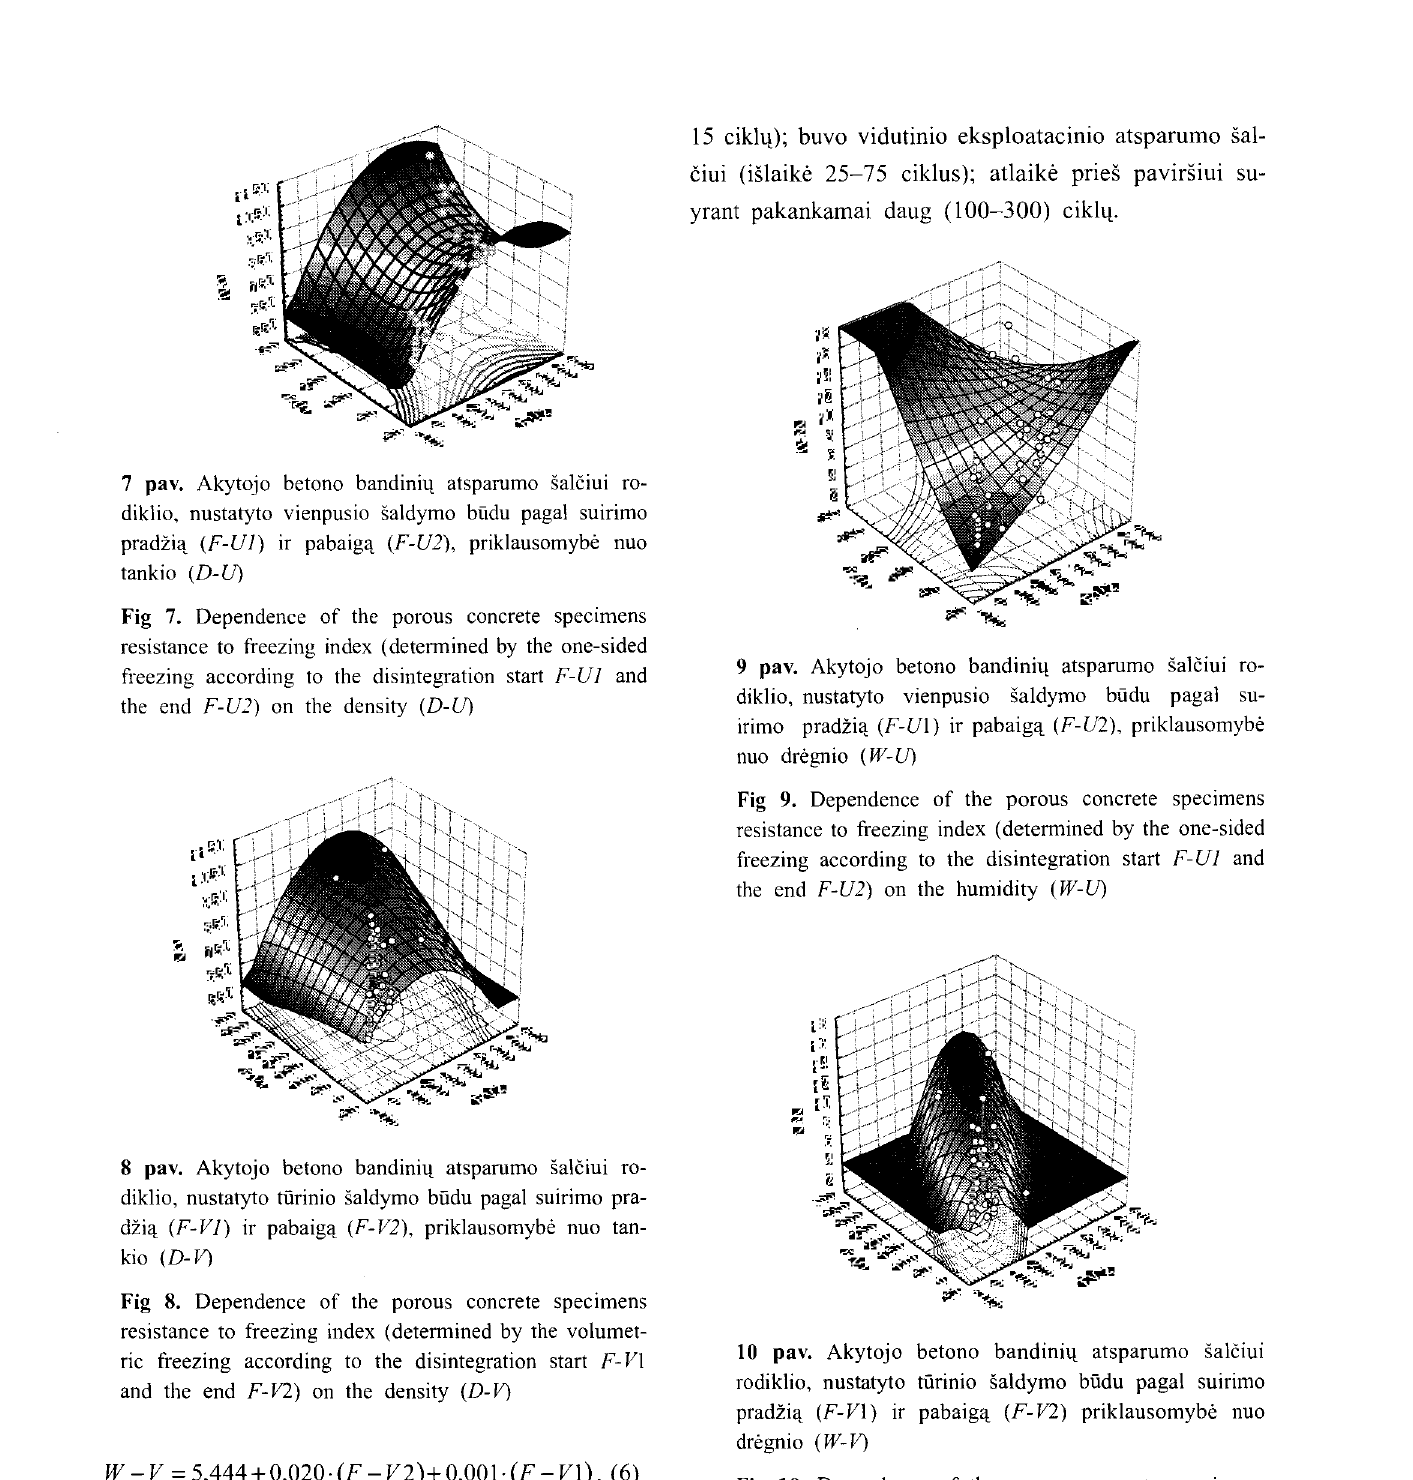
W- V = 5,444+0,020-(F- V2)+0.001·(F- Vl). (6) suirimus sa1dant skirtingais budais. 3.2. LinijiniQ deformacijQ eigos ypatumai ciklinio